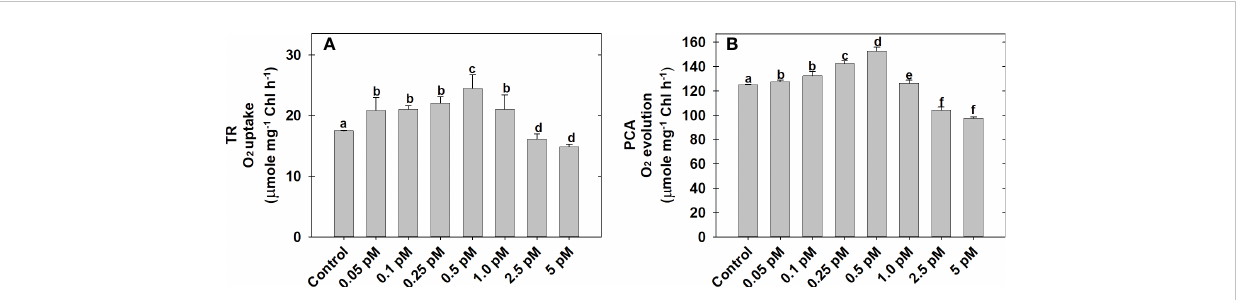
FIGURE 1 Effect of different concentrations of BL on TR (A) and PCA (B) in MCP of A . thaliana . The MCP in the reaction medium was pre-incubated with a series of BL concentrations (0.05 to 5 pM) for 10 min under a light intensity of 1000 m mol m -2 s -1 at 25°C. After treatment, the TR was recorded as O 2 uptake for 5 minutes in the dark and PCA was traced as NaHCO 3 -dependent (1.0 mM) O 2 evolution for 10 min in light (1000 m mol m -2 s -1 ) using a Clark-type oxygen electrode. More detailed information on the procedure is mentioned in the “ materials and methods ” section. A statistically signi fi cant difference is represented by different lowercase alphabetical letters (P < 0.05) and values represent the average (± SE) of three